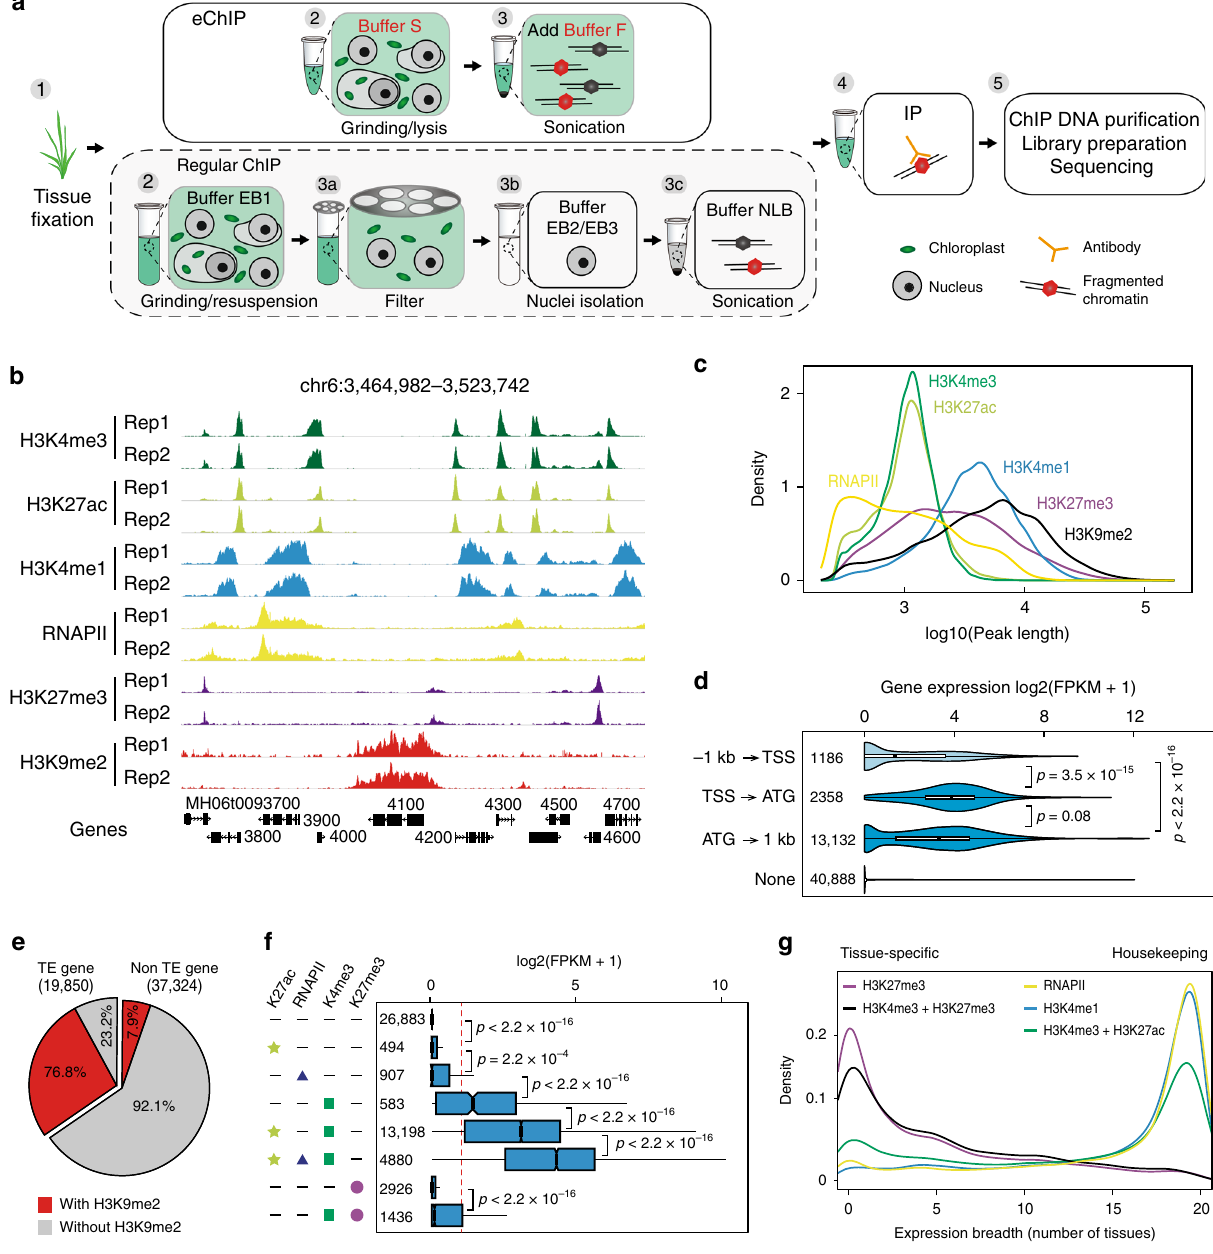
Fig. 1 Histone modi fi cation landscapes pro fi led by eChIP-Seq in rice. a Schematic diagram of the eChIP and regular ChIP methods. Both methods start fi xing tissues with formaldehyde, followed by grinding tissues to fi ne powder, homogenate lysis, chromatin sonication, IP (immunoprecipitation) with antibodies, ChIP DNA puri fi cation, library preparation, and sequencing. For eChIP, the lysed homogenate is directly sonicated for IP. In regular ChIP, the homogenate is fi rst fi ltered through a mesh, and the isolated nuclei are then sonicated for IP. Steps 3a, 3b and 3c in regular ChIP are replaced by step 3 in eChIP. More details are shown in “ Methods ” . b Genome browser screenshot showing eChIP-Seq data for a young leaf of MH63. c Density distribution of the lengths of histone mark-modi fi ed and RNAPII-occupied regions in young leaf of rice. d Distribution of gene expression from the young leaf. The genes were divided into different categories based on the H3K4me3 peak positions relative to TSS and ATG of genes. TSS transcription start sites. Peak numbers of each categories are shown. e Distribution of TE genes and non-TE genes, marked with or without H3K9me2, in the young leaf of rice. f Expression levels of genes with promoters marked by different histone modi fi cations and RNAPII. Numbers of genes in promoter categories are shown. Short line means that there is no certain histone modi fi cation or RNAPII occupancy. Boxplots in ( d ) and ( f ) include a median with quartiles and outliers above the top whisker. The statistical analysis was performed using two-side Wilcoxon test. The numbers indicate the sample size used in the analysis. g Breadth of expression (number of tissues that a gene is expressed in) of genes modi fi ed by different histone marks and RNAPII. Source Data underlying Fig. 1f, g are provided as a Source Data fi